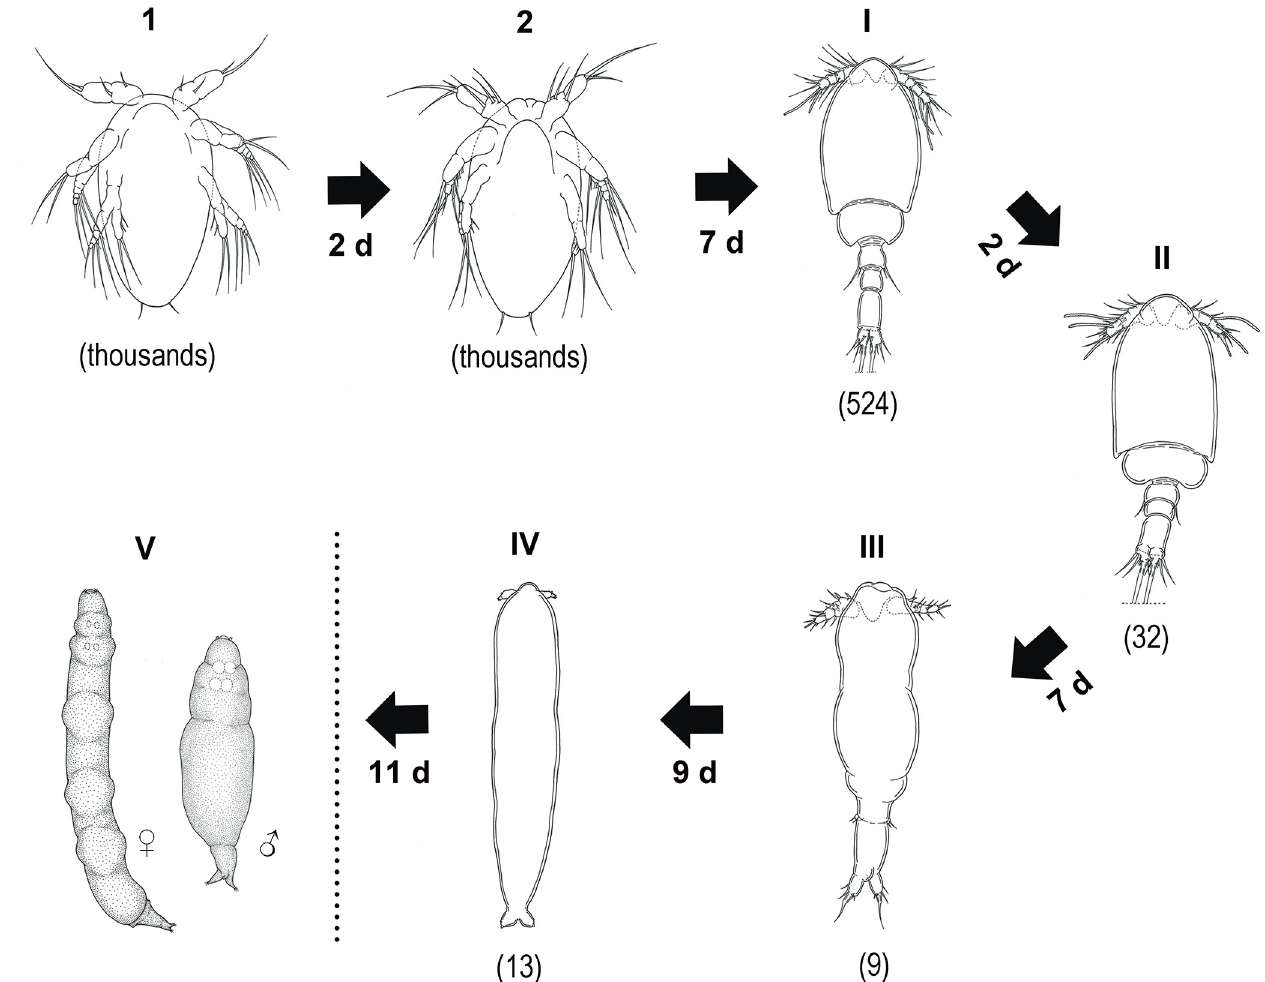
Fig 10. Duration of post embryonic stages of Ive ptychoderae . (1–2) naupliar stages; (I-IV) copepodid stages; (V) adult stage. The duration time (days) of each stage is provided and the number of copepod individuals at each developmental stage is indicated in parentheses. Dotted line indicates the end of incubator